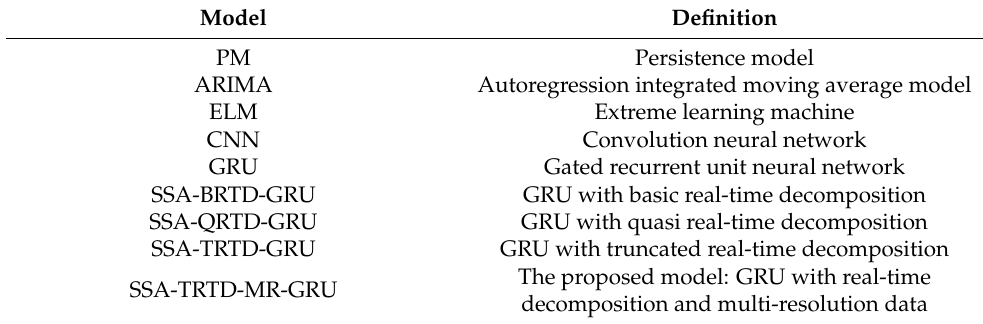
Table 3. The summary of models. Model